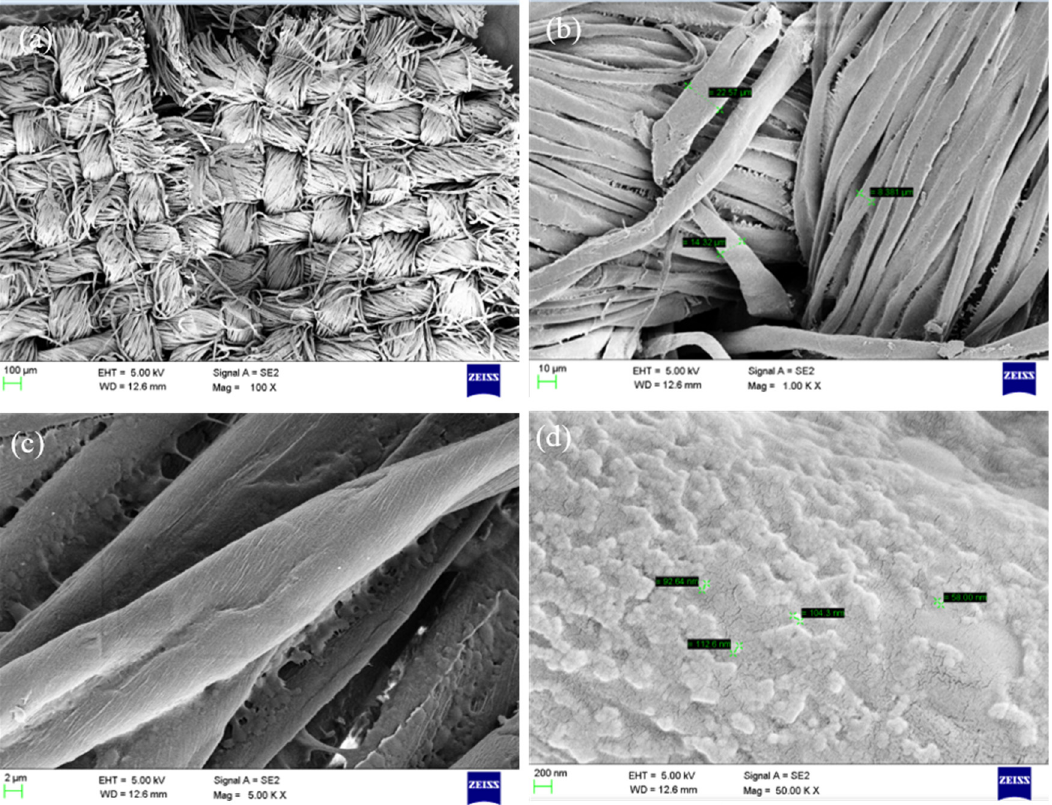
Figure 8. SEM images of ( a ) BVD 141 printed cotton fabrics, ( b ) and ( c ) increased resolution, and ( d ) after curing at 150 °C per 5 min.